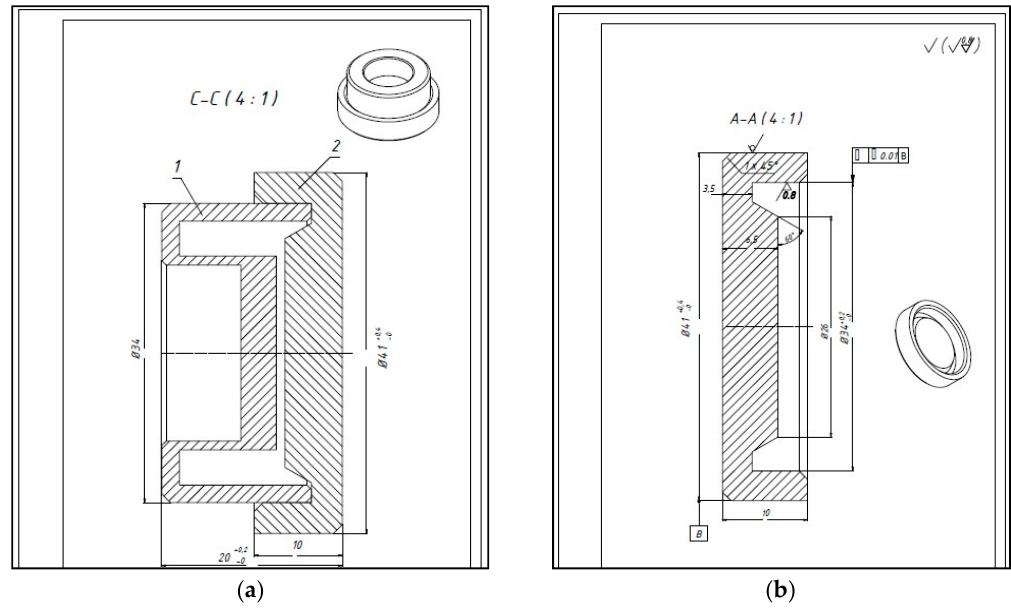
Figure 2. Schematic presentation of ( a ) the chamber and ( b ) the cover.